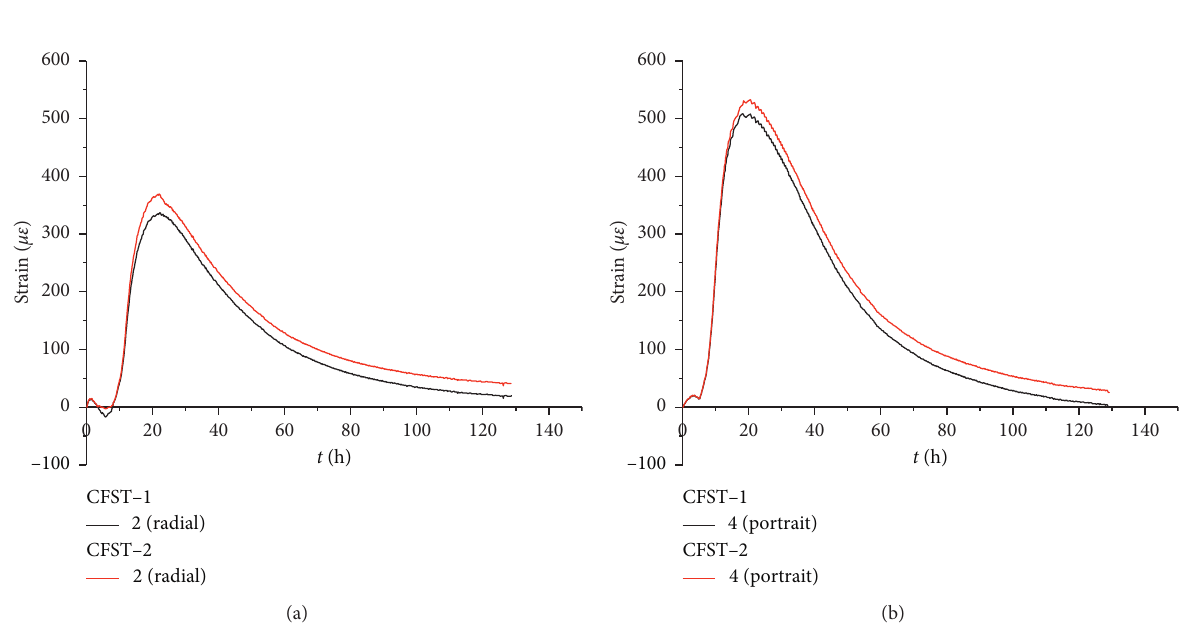
Figure 11: Strain vs time curve for in-pipe concrete. (a) Radial strain. (b) Portrait